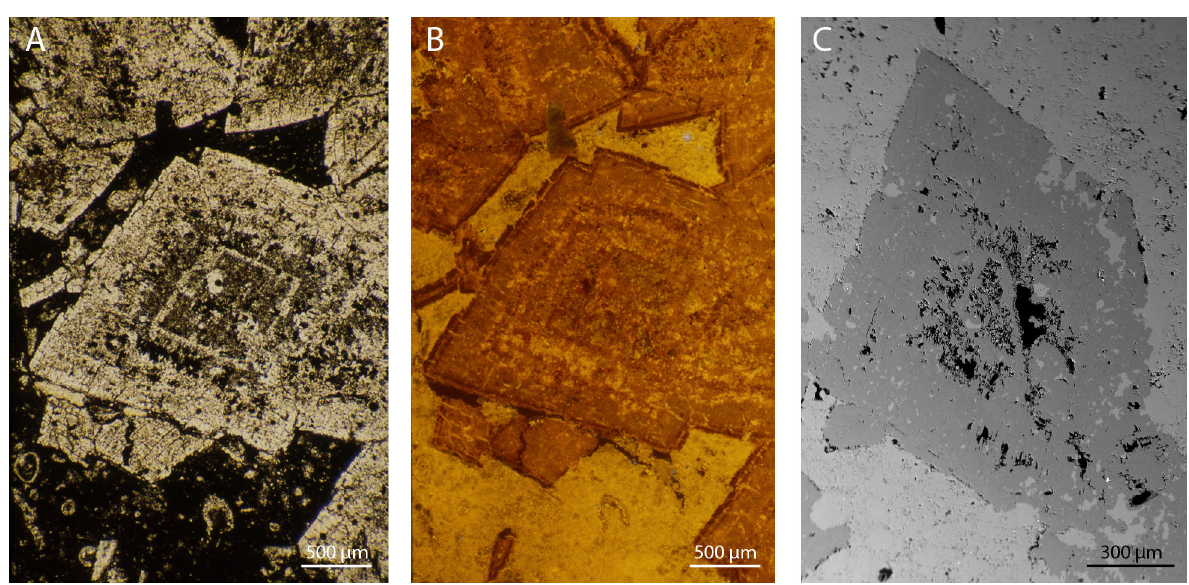
Fig. 8. Concentric zoned dolomite rhomb (type 3) floating in fossil-rich limestone matrix in light microscope ( A ), cathodoluminescence (CL) ( B ) and scanning electron microscopy (SEM) in the backscattered electron imaging mode ( C ). In CL crystals are surrounded by dark outer cortex. The SEM micrograph shows abundant tiny vugs (black) in the centre the crystal. Some of the vugs are oriented along zoned planes inside the crystal. (A) and (B) Hino drill core, 45.8 m, GIT 441-637; (C) Hino drill core, 49.0 m, GIT